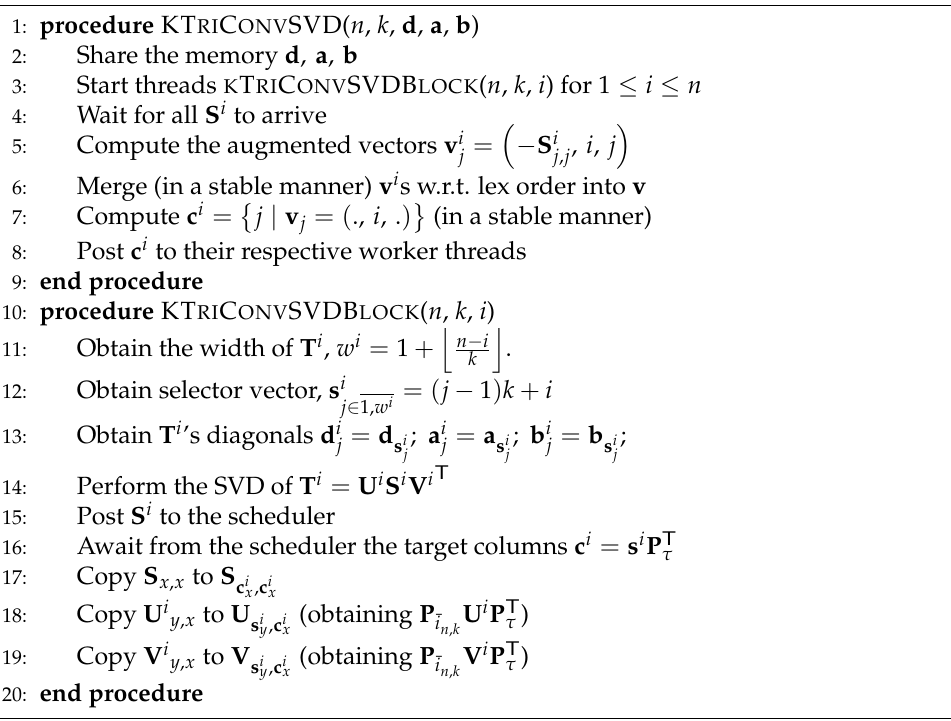
Algorithm 1 Parallel conventional SVD for k -tridiagonal